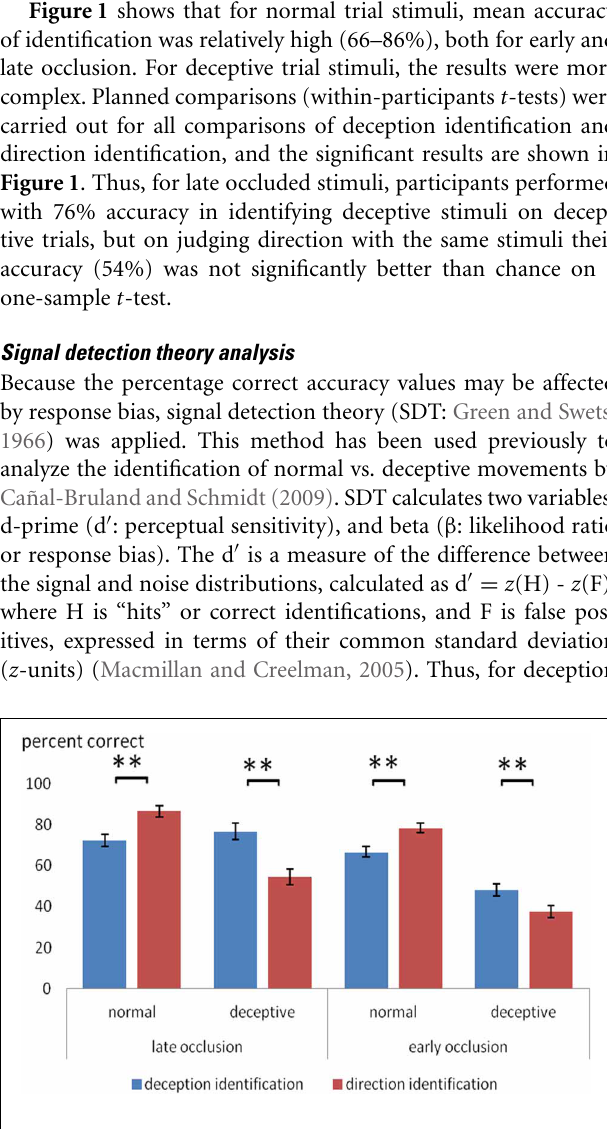
FIGURE 1 | Mean percentage accuracy on normal and deceptive trials in scanner sessions where the task was to identify of the type of move (normal or deceptive) and in sessions where the task was to identify the direction of play (left or right). Error bars are ± 1 s.e.m. Difference between deception identification and direction identification (bracketed bars) is significant at ∗∗ p < 0 .